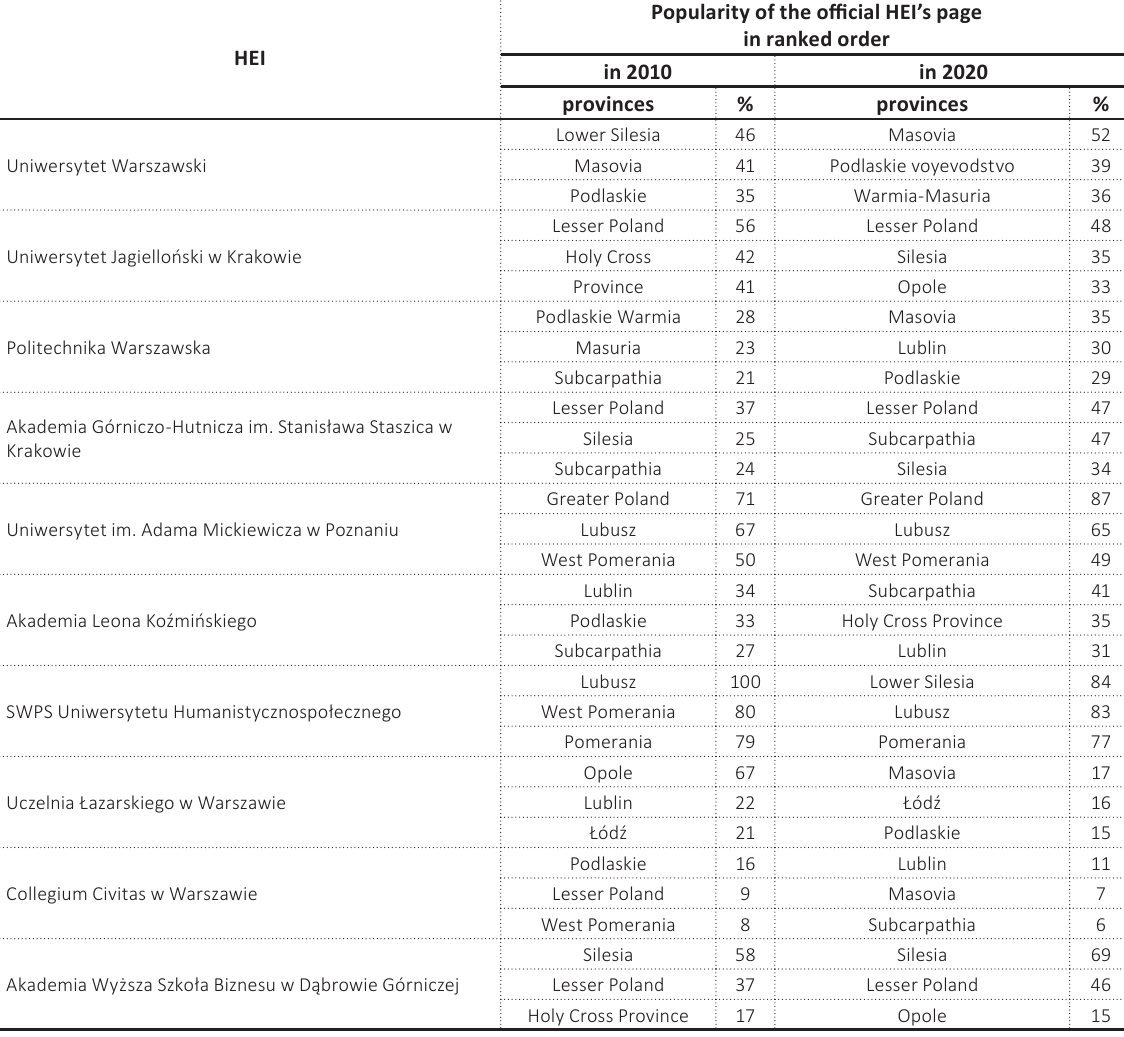
Source: Google Trends (n.d.).